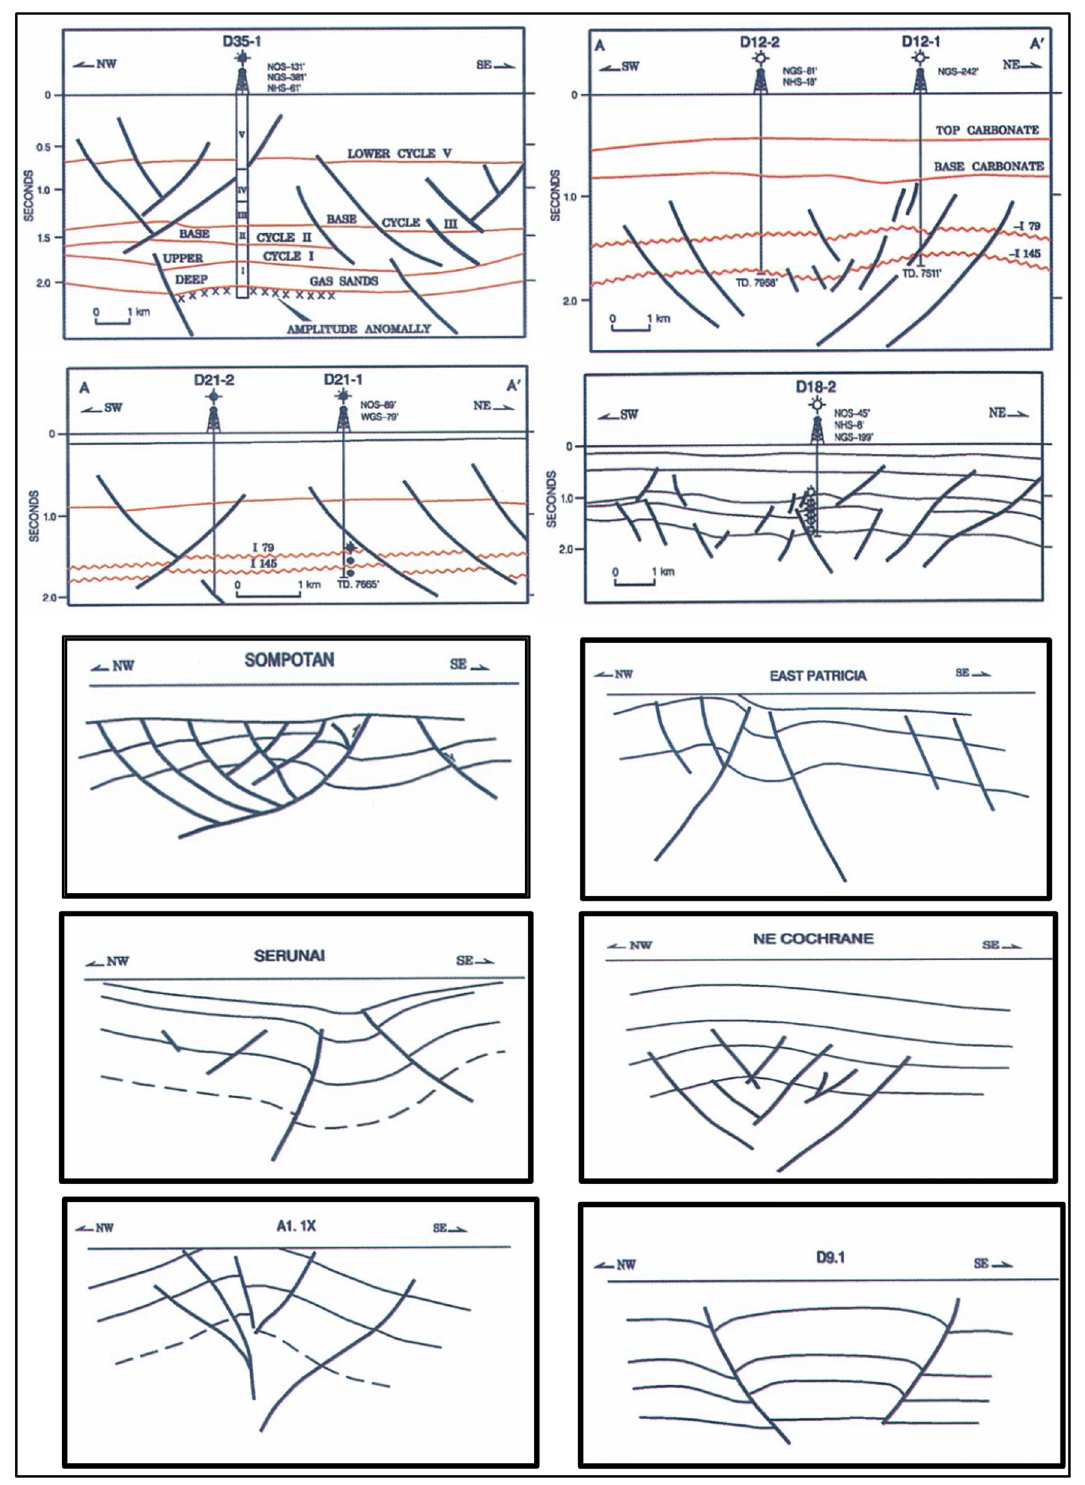
Fig. 13 Structural trapping styles identified in the Balingian Province (Madon and Abolins 1999; OXY 1989; Shell